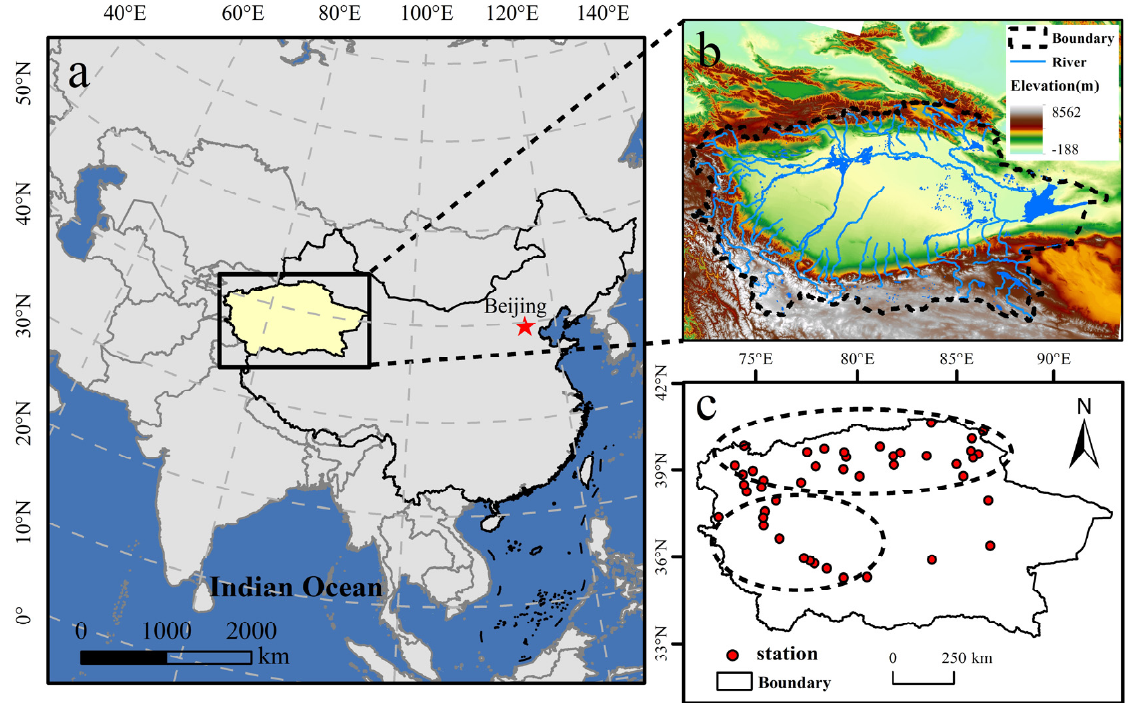
Figure 1. Location of the Tarim Basin.(( a )—the location of the study area; ( b )—the drainage systerm and elevation of Tarim Basin; ( c )—distribution of meteorological stations in The Tarim Ba- sin.)